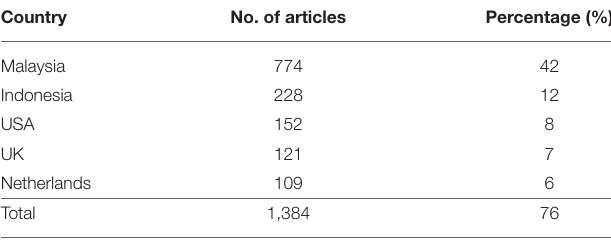
TABLE 1 | Top five countries publishing on palm oil